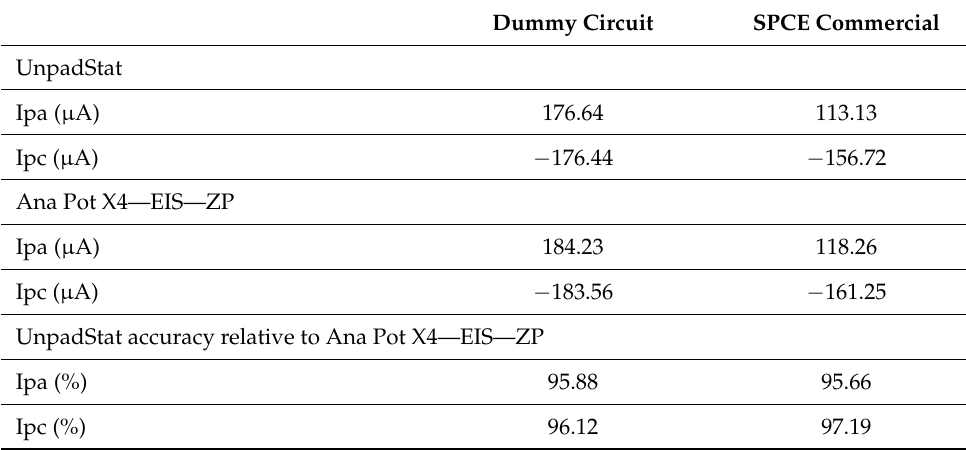
Figure 9. ( A ) CV measurement on dummy circuit using UnpadStat and commercial potentiostat, ( B ) CV measurement on commercial SPCE using UnpadStat and commercial potentiostat. Table 3. Comparison of CV measurement results.